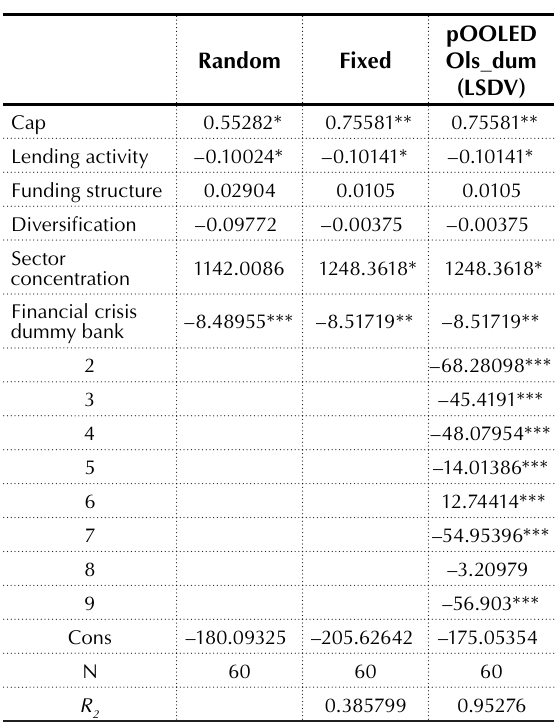
Table 3. Comparison of three